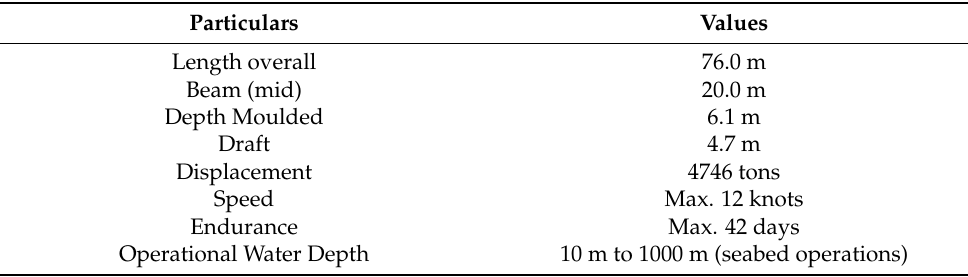
Table 2. Principal particulars of the geotechnical vessel under consideration.